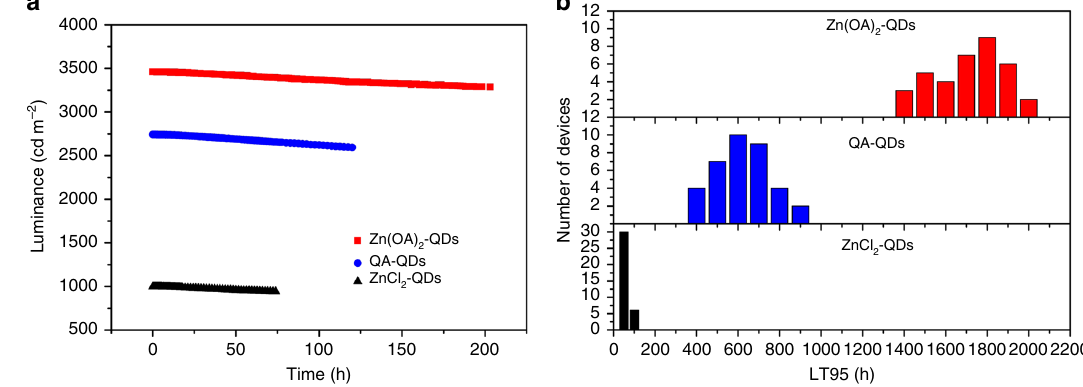
Fig. 7 IJP devices lifetime. a Lifetime of OA-QDs, ZnCl 2 -QDs, and Zn(OA) 2 -QDs devices under 25 mA cm − 2 ; b statistics of device performance. Histograms of extrapolated LT 95 at an initial brightness of 1000cd m − 2 of OA-QDs, ZnCl 2 -QDs, and Zn(OA) 2 -QDs devices with 36 devices for each device has the longest LT 95 , which is over 196 h, while it takes <70 h for the ZnCl 2 -QDs device reaching its LT95. And LT 95 of OA-QDs device is 113 h. The extrapolated LT 95 at an initial brightness of 1000 cd m − 2 of Zn(OA) 2 -QDs devices is 1833 h, with acceleration factor of n = 1.80 by fi tting LT 95 values at various luminance (Supplementary Fig. 6a). To better compare the lifetime, we also converted the lifetime results of OA-QDs and ZnCl 2 -QDs devices to the initial brightness of 1000 cd m − 2 .